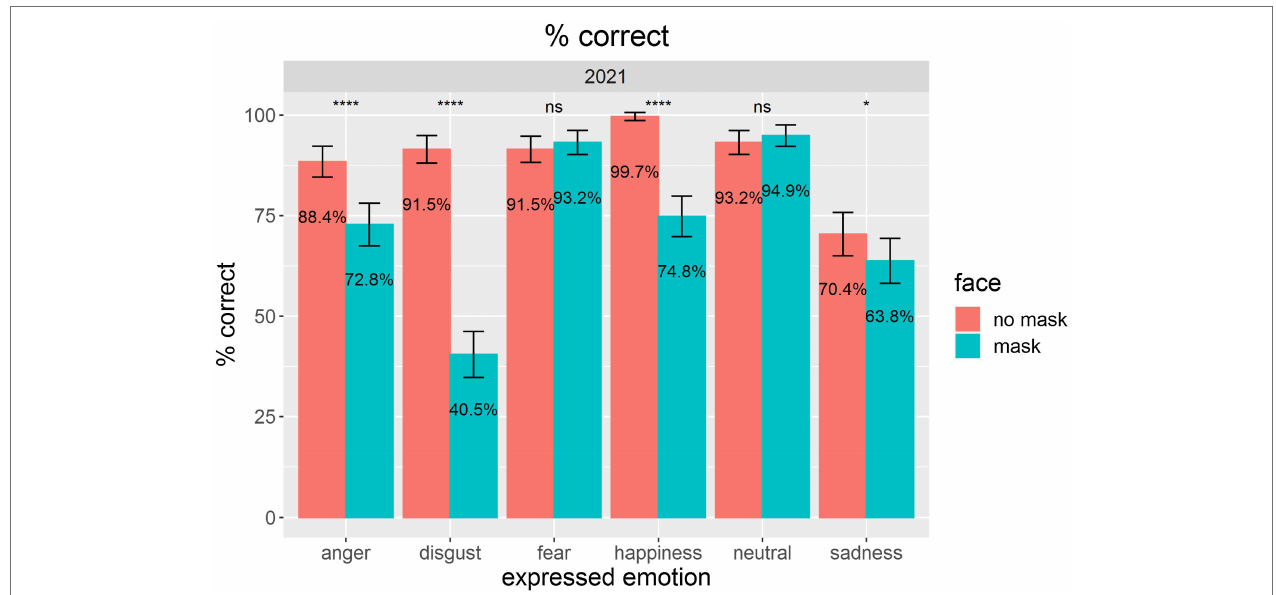
FIGURE 2 | The figure demonstrates mean performance levels for assessments of emotional states for faces without masks (red) compared with faces with masks (blue). Error bars indicate 95% confidence intervals (CIs) according to Morey (2008). Pairwise comparisons of the presentation conditions were calculated